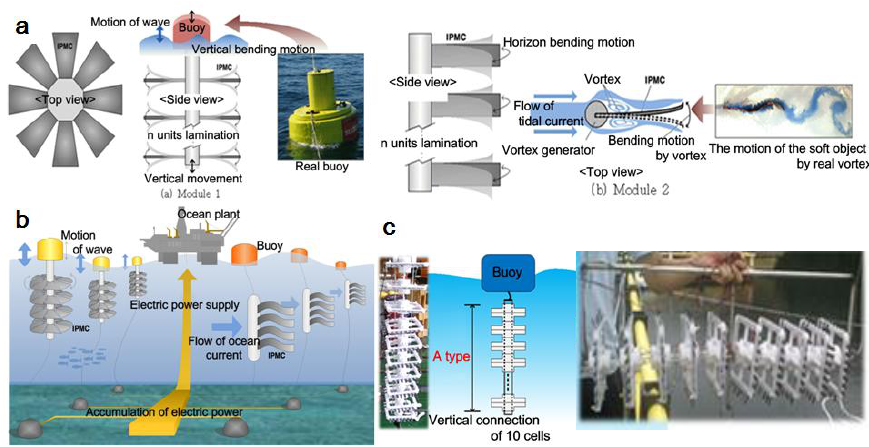
Figure 3. Experimental design of the IPMC system: ( a ) the fundamental design, ( b ) the system assembly in the ocean, and ( c ) the module assembly .